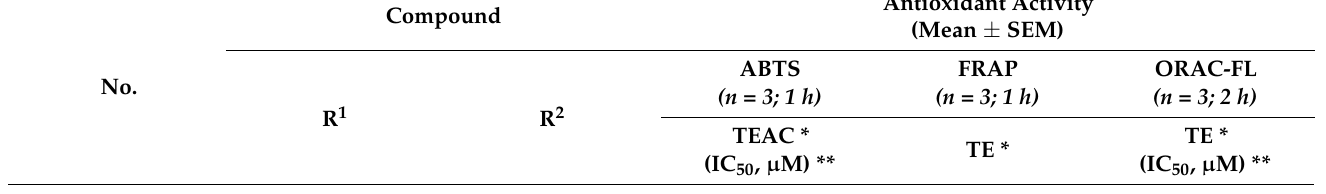
Table 1. Antioxidant activity of pyrazoles 1 and 4 .